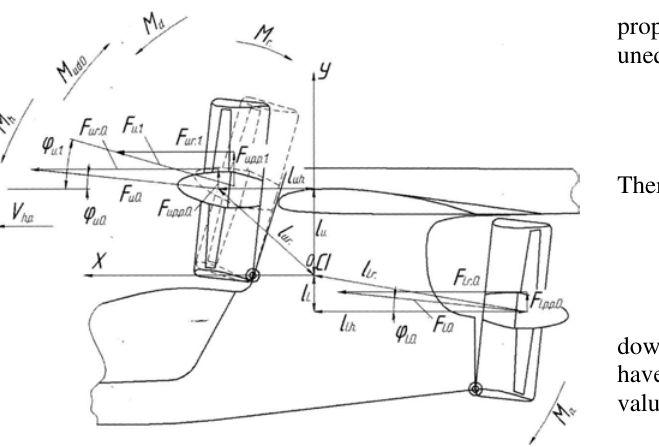
Fig. 7. Diagram of adverse and recovery moments due to the PP thrust of the developed